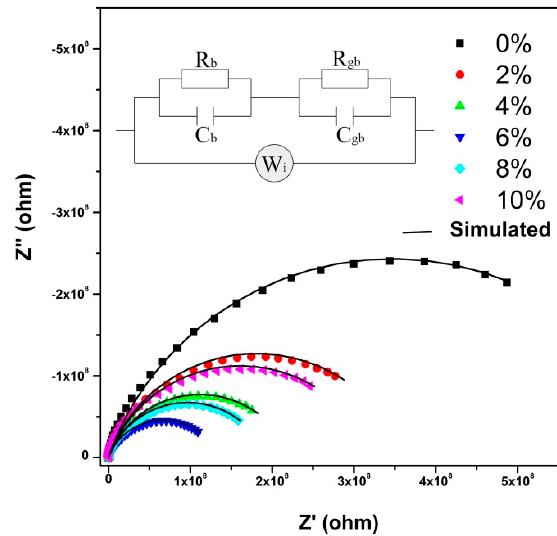
Figure 4. The complex impedance spectra of SrF 2 :Tb 3+ nanocrystals. The inset is the equivalent circuit. R g and C g are the grain resistance and capacitance, R gb and C gb are the grain and grain boundary, W i is the Warburg element.